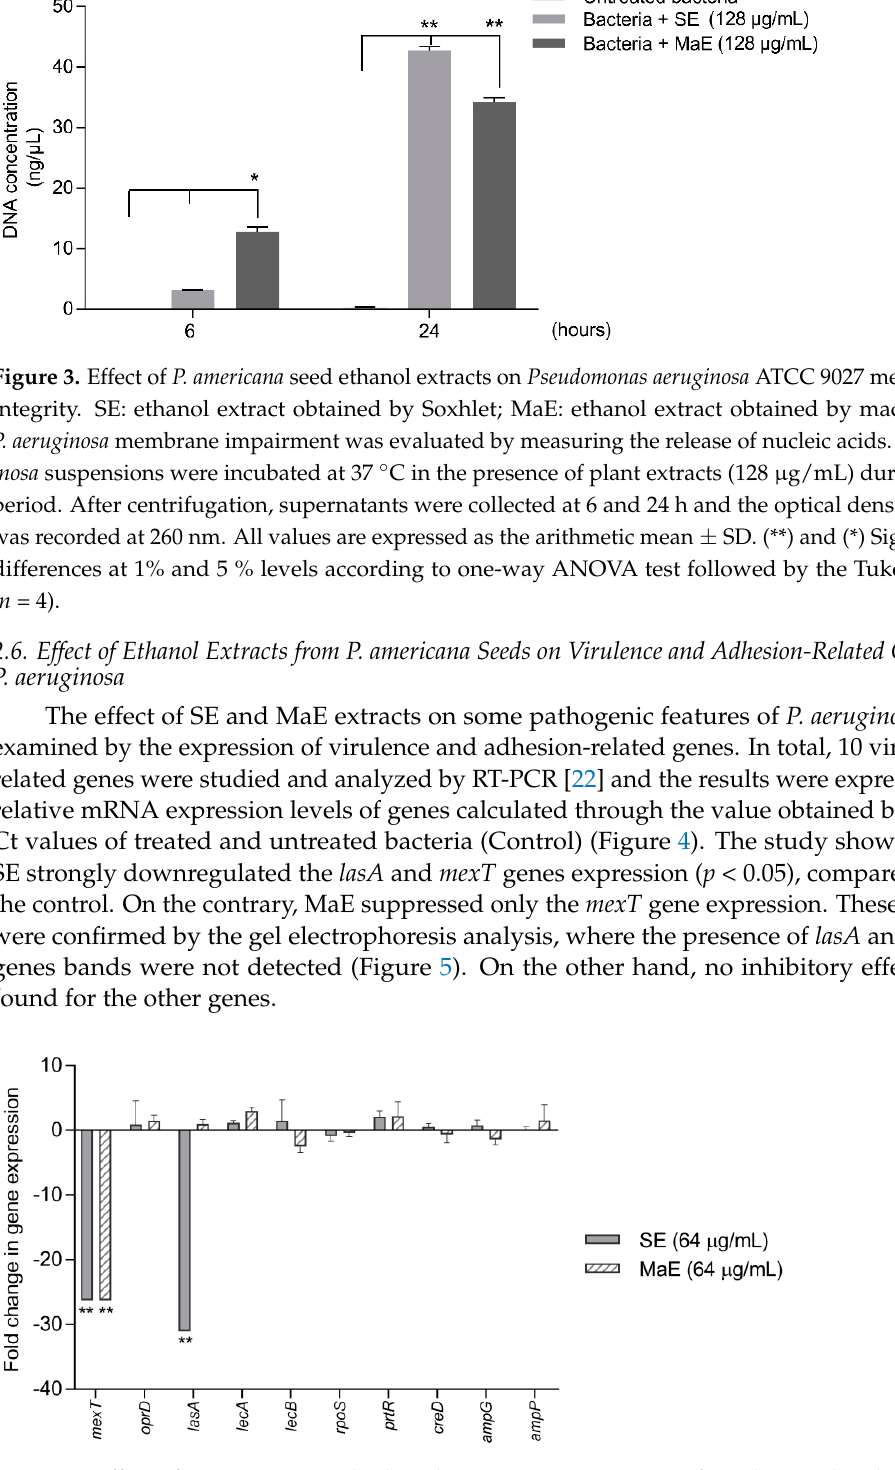
Figure 5. Electrophoresis analysis of lasA and mexT genes in Pseudomonas aeruginosa ATCC 27853. SE: ethanol extract obtained by Soxhlet; MaE: ethanol extract obtained by maceration. PCR products were analyzed by agarose gel electrophoresis (1%) stained with GelRed and using a Tris-borate- EDTA buffer. Gels images of lasA and mexT genes were visualized. Lanes: (1) Control: untreated bacteria, (2) SE treatment, (3) MaE treatment. creB gene was used as internal control. 3. Discussion Although antibacterial effects of phytochemicals have been mainly demonstrated to directly affect their viability [21], crude extracts and their isolated compounds could also be promising anti-adhesive and anti-biofilm agents. This strategy would strongly de- crease the bacterial colonization by affecting its biofilm formation and adhesion when treating infectious diseases [7,23]. In this study, we have demonstrated that P. americana seed-derived ethanol extracts (i) decreased the bacteria cell viability, (ii) reduced the bac- terial adhesion to A549 lung epithelial cells probably by inhibiting the mRNA expression levels of genes of virulence factors related to adherence and quorum sensing, (iii) inhibited the biofilm formation, and (iv) were no cytotoxic to mammalian cell lines. In previous studies, we have found that ethanol extracts from avocado seeds con- tained several bioactive phytochemicals. Secondary metabolites such as alkaloids, couma- rins, tannins, and flavonoids were qualitatively identified by a phytochemical screening [24]. Further characterization analysis also showed the presence of some phenolic